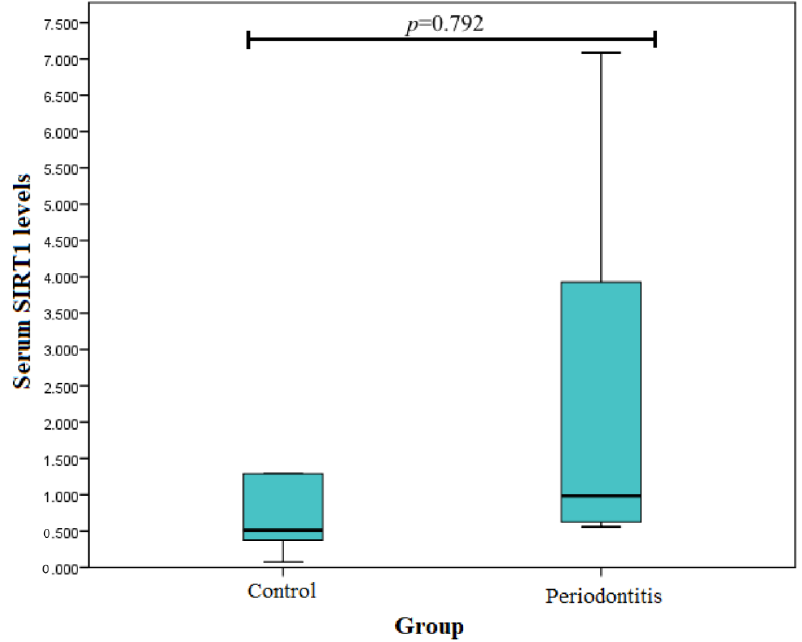
Figure 1. SIRT1 serum levels in periodontitis and control group